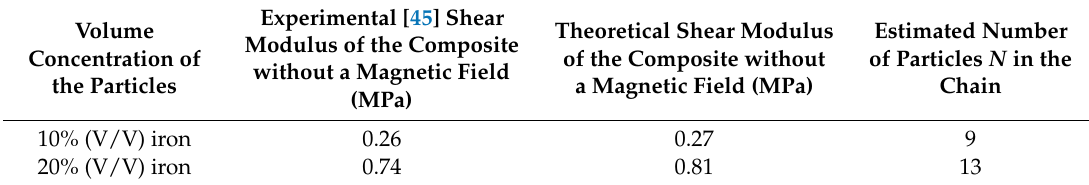
Table 1. Comparison between the experimental [44] and our theoretical results for shear modulus G ( 0 ) (no field is